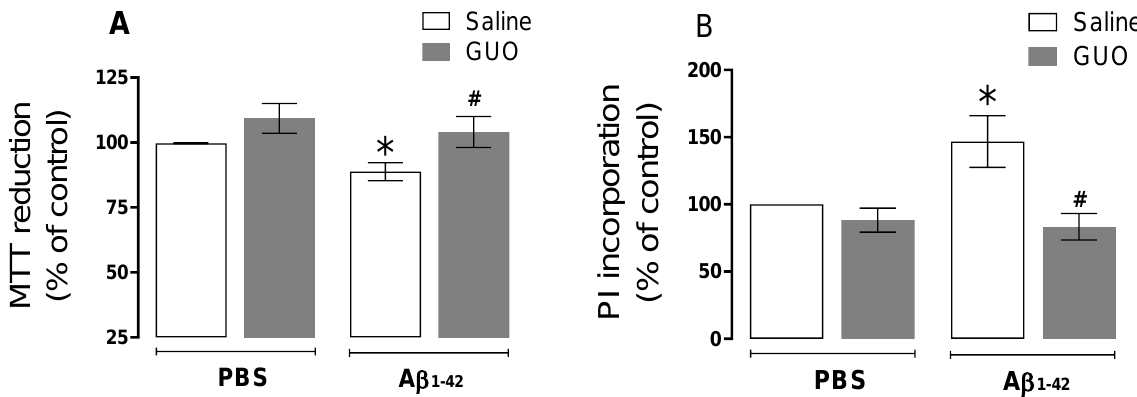
Figure 7. Guanosine prevents A β 1–42 -induced mice hippocampal slice loos of cell viability and mem- brane permeabilization. Mice subjected to A β 1–42 infusion (400 pmol/site) received guanosine (GUO, 8 mg/kg, i.p.) for nine days. On the tenth day, animals were euthanized, and hippocampal slices were analysed for cellular viability through MTT assay ( A ), and membrane damage through PI incorpora- tion ( B ). Values expressed as mean + S.E.M (n = 8–9) * p ≤ 0.05 compared with vehicle-treated group. # p ˂ 0.05 compared with A β 1 – 42 group. (Two- way ANOVA followed by Tukey’s test).